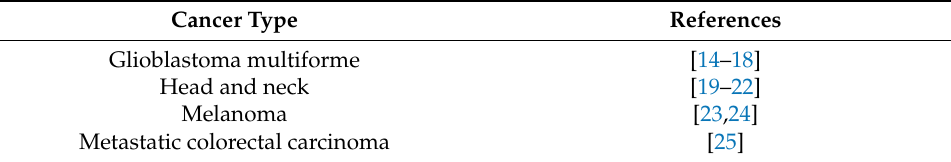
Table 1. Selected clinical studies of BNCT in various types of